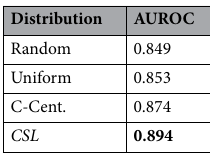
Table 4. Latent space distribution comparison. Significant values are in